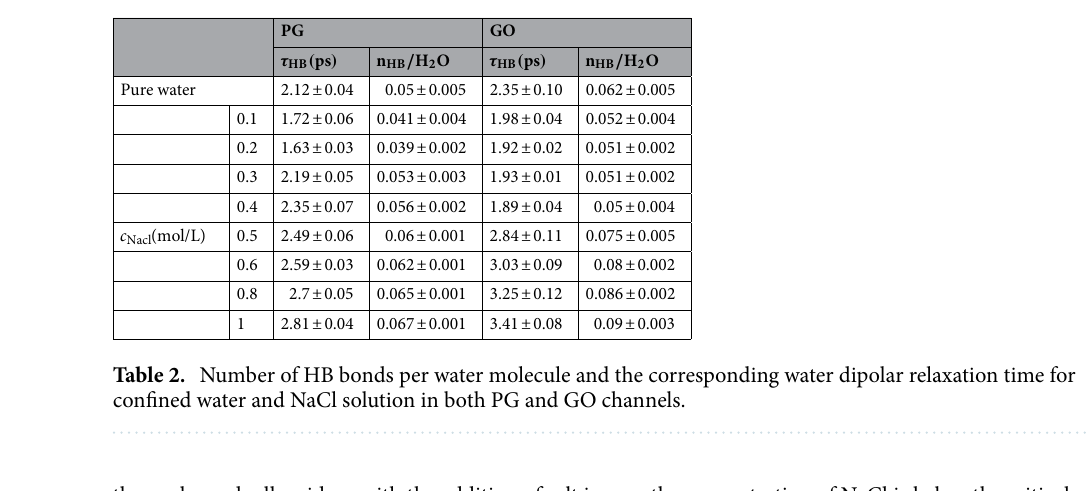
Figure 7. Probabilities of angle distributions θ for different concentration of NaCl solution in both PG ( a ) and GO channels ( b ).